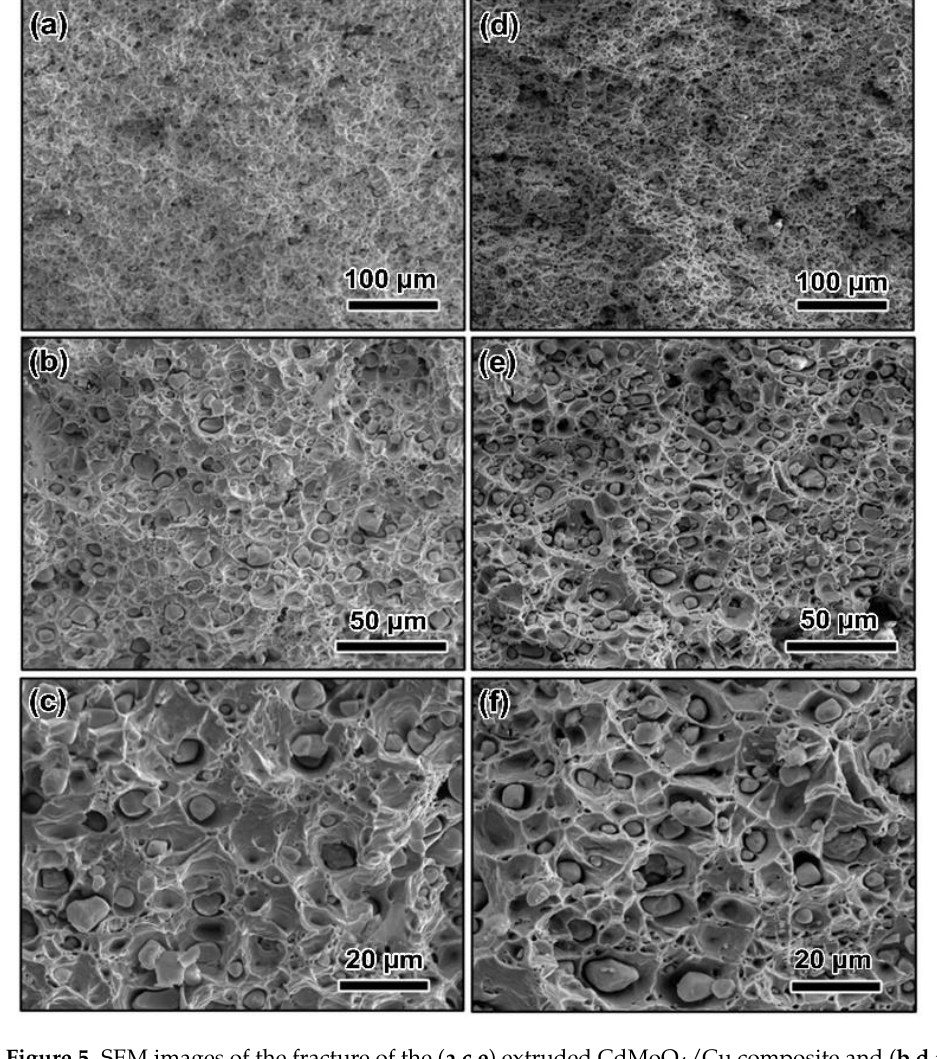
Figure 5. SEM images of the fracture of the ( a , c , e ) extruded CdMoO 4 /Cu composite and ( b , d , f ) the rolled CdMoO 4 /Cu composite.